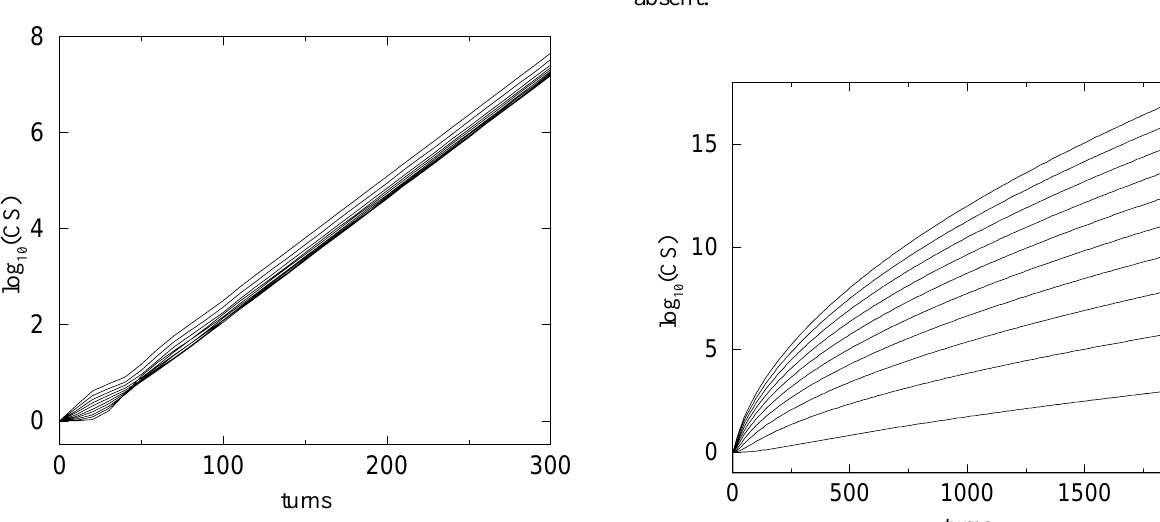
FIG. 5. Log of CS invariants versus turn number for a system at twice the head-tail threshold with no space charge and (cid:81) (cid:115) (cid:173) (cid:48)(cid:46)(cid:48)(cid:49) .